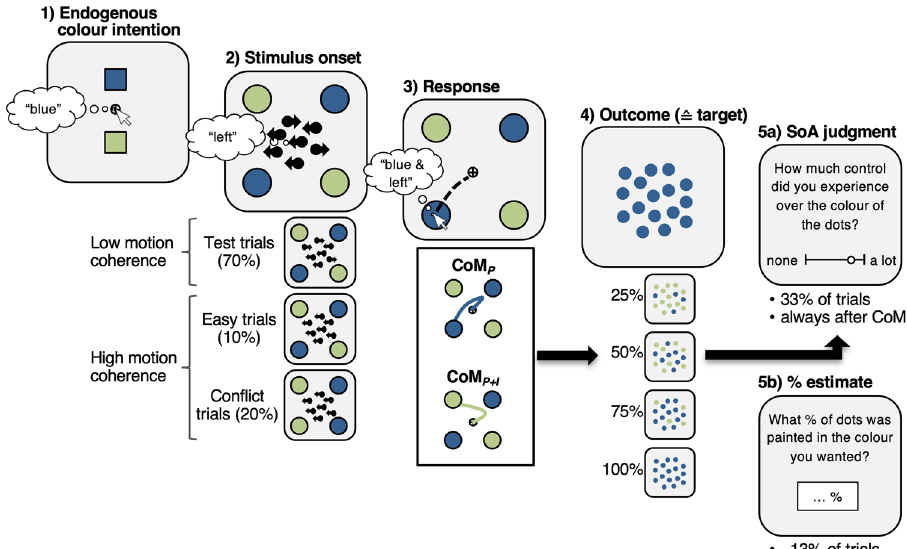
Fig. 1 Behavioural task. Participants generated an endogenous colour intention ( 1 ) that had to be integrated with the sensory input of the dot-motion stimulus ( 2 ). Responses were indicated by moving the cursor to the target that matched both the colour intention and dot-motion direction ( 3 ). Continuous movement trajectories were measured during response execution allowing for online classi fi cation of perceptual Changes of Mind (CoM P ) and perceptual + intentional Changes of Mind (CoM P + I ). Once participants reached the target, 25/50/75/100% of the dots were painted in the colour of the hit target ( 4 ). On some trials, participants were asked to provide Sense of Agency (SoA) judgements ( 5a ) or to estimate the percentage of dots that matched their initial colour intention ( 5b